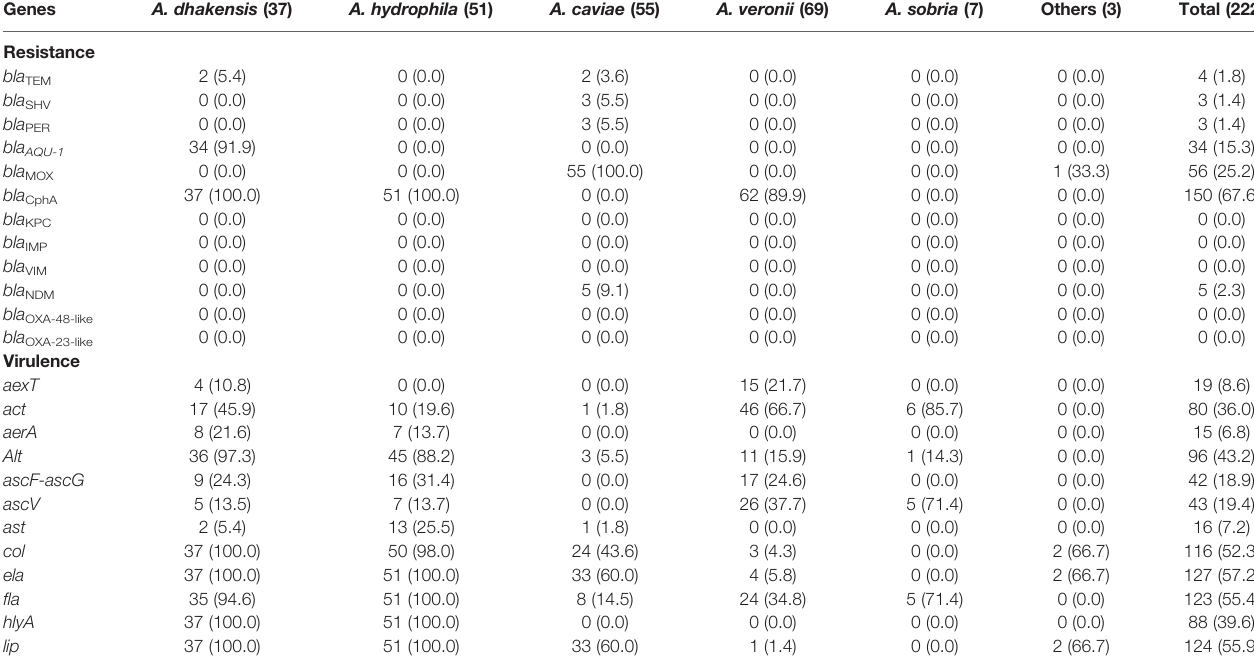
TABLE 3 | Resistance and virulence genes among different Aeromonas species.